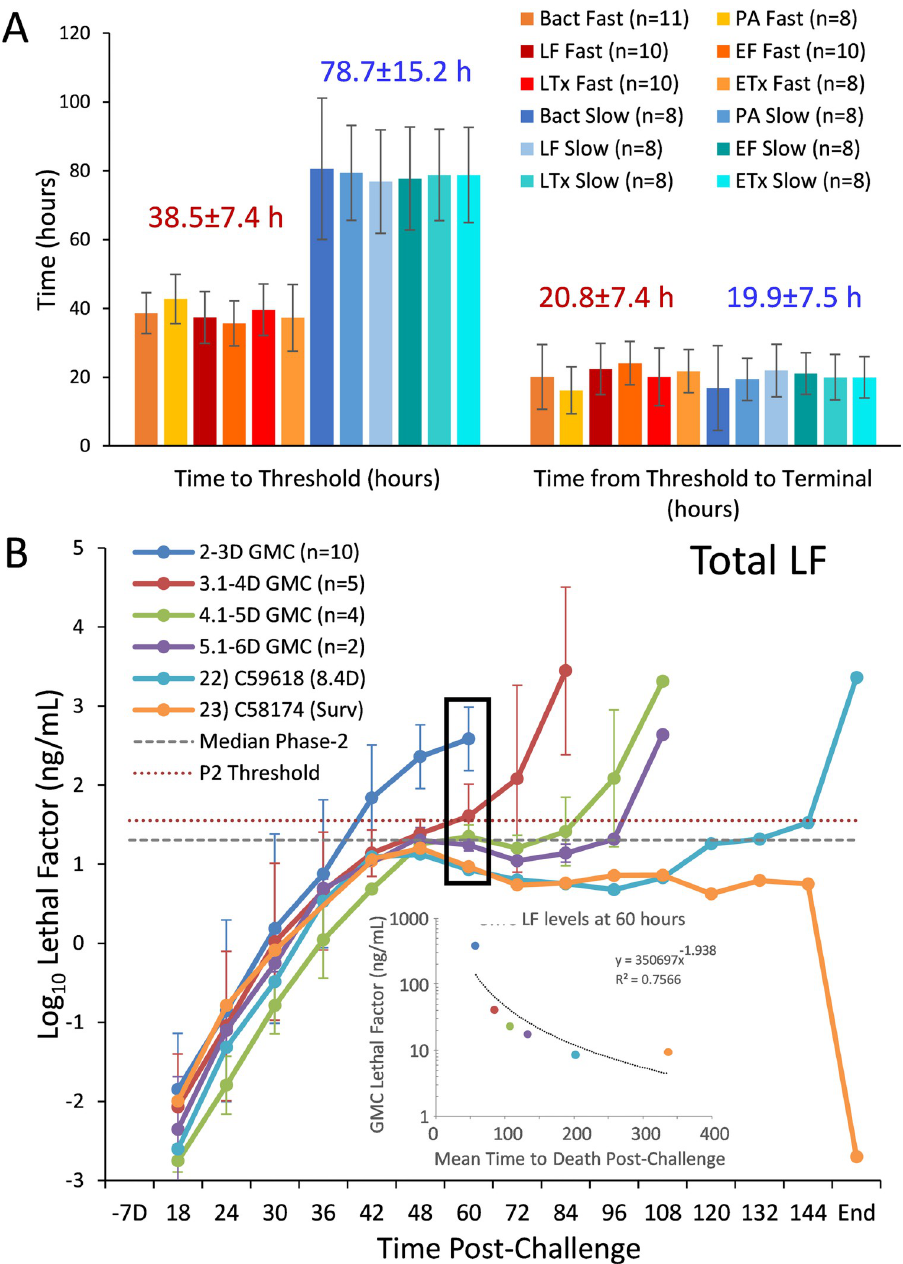
Fig 5. Relationship of toxemia and time. (A) Time in hours (h) from spore exposure to reach the phase-2 threshold for exiting phase-2 and entry to phase-3 (Table 5) and time from threshold to terminal. The time to reach the threshold was calculated for individual animals for all toxins and bacteremia and means and standard deviation (SD) (error bars) for the number (n) animals was determined for fast and slow progression. The overall mean ± SD for all toxins and bacteremia combined for fast and slow progression is included above the bars. (B) Relationship between LF levels and survival time (days). Mean log 10 concentrations and standard deviations as error bars for total LF over the time post- challenge (hours-h) for animals that survived 1.9–3.0 days (n = 10), 3.1 to 4.0 days (n = 5), 4.1 to 5 days (n = 4) and 5.1 to 6 days (n = 2), and for one animal at 8.4 days and survivor to end-of-study (End). Final time points for 22) C59618 at 8.4 days and 23) C58174 the survivor at end-of-study (14 days) were included together (End). Horizontal lines shown for median phase-2 LF (dashed grey) and LF phase-2 threshold (red dotted line). The black rectangle for LF at 60 h for mean log 10 LF graphed vs mean subsequent survival time (60-h to terminal) (inset), fitted with a power regression.